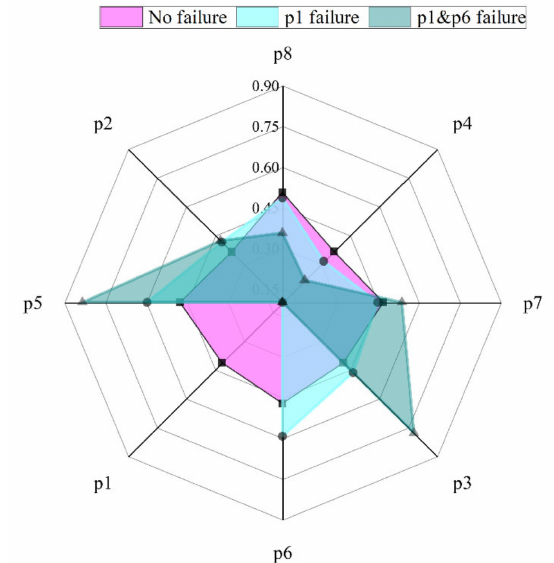
Figure 17. Average tension of each tension leg (unit: 10 4